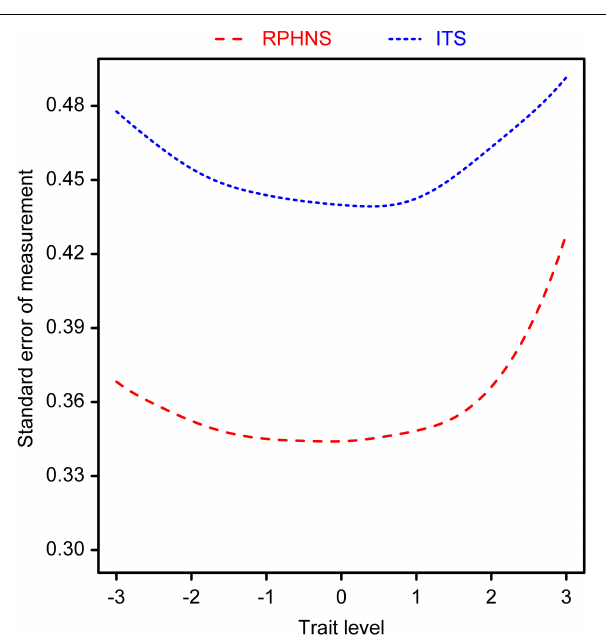
FIGURE 2 | Deviation chart of scales by different trust